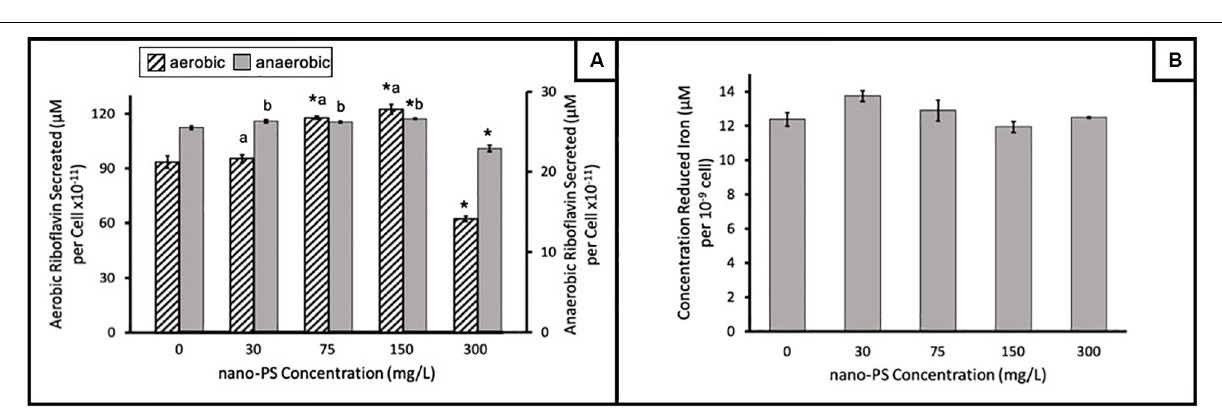
the flavin response, future transcriptomics work is being